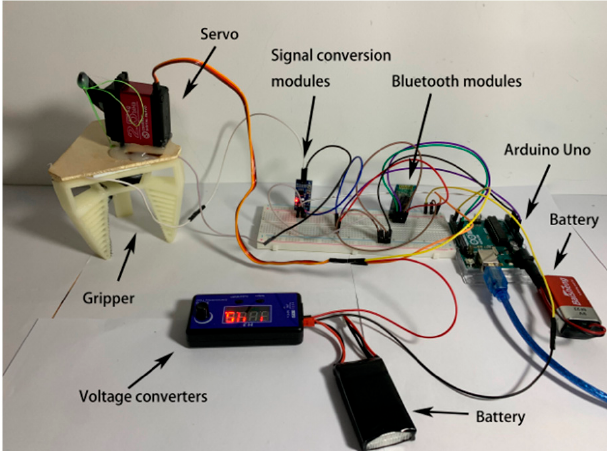
Figure 4. The integral soft robotic gripper system.